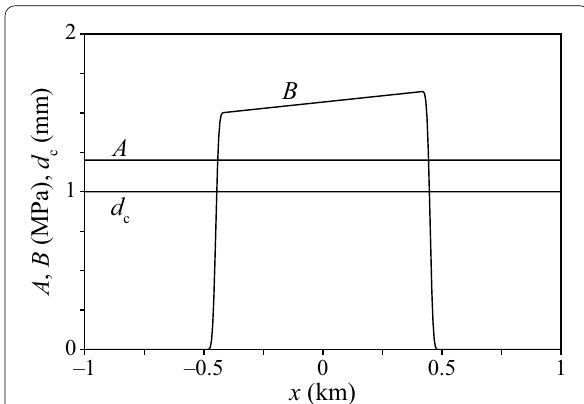
Fig. 2 Distributions of the frictional properties along the fault in the test problem used to verify the proposed method. A and B are the amplitudes of the direct effect and evolution effect, respectively, and d c is the characteristic slip of the state